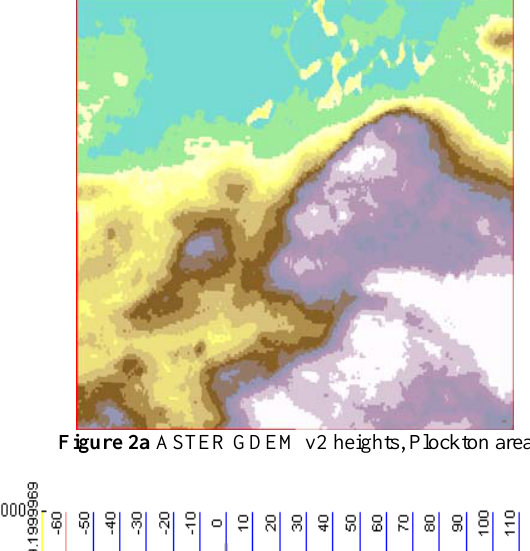
Figure 2c. Histogram of differences, Plockton, between ASTER v2 and OSGB terrain models Largest negative